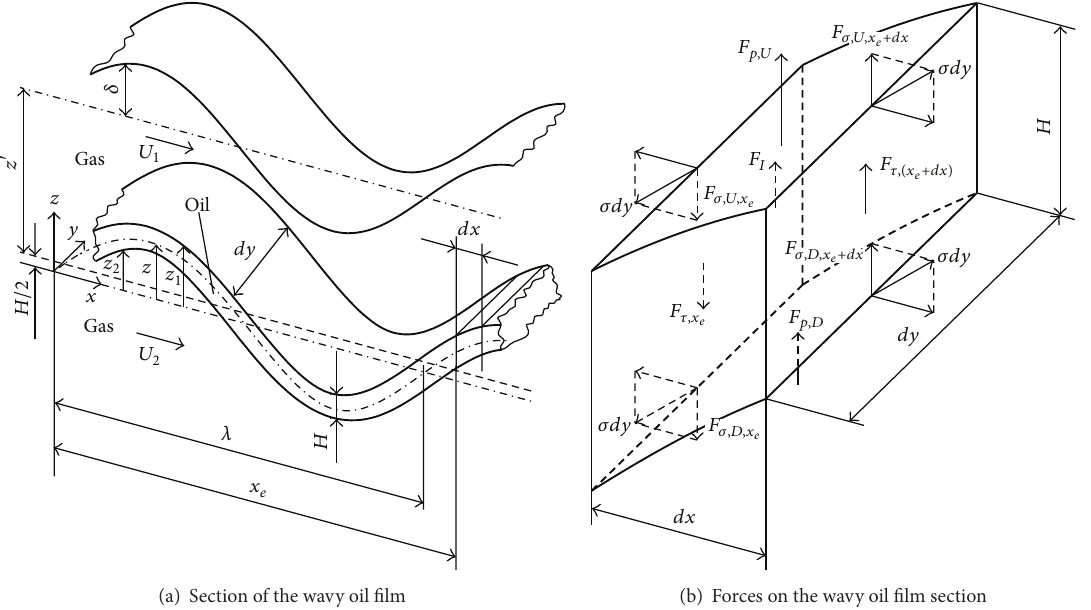
Figure 6: Section of the wavy oil film and the